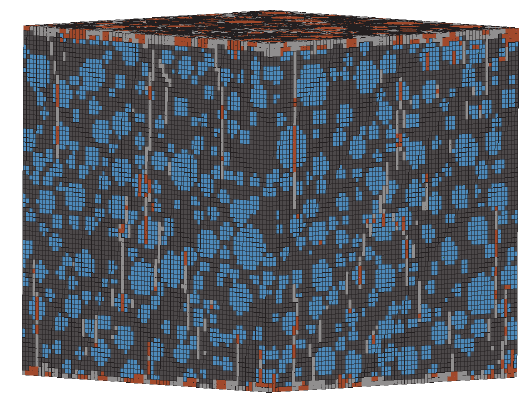
Figure 4: Damage morphology